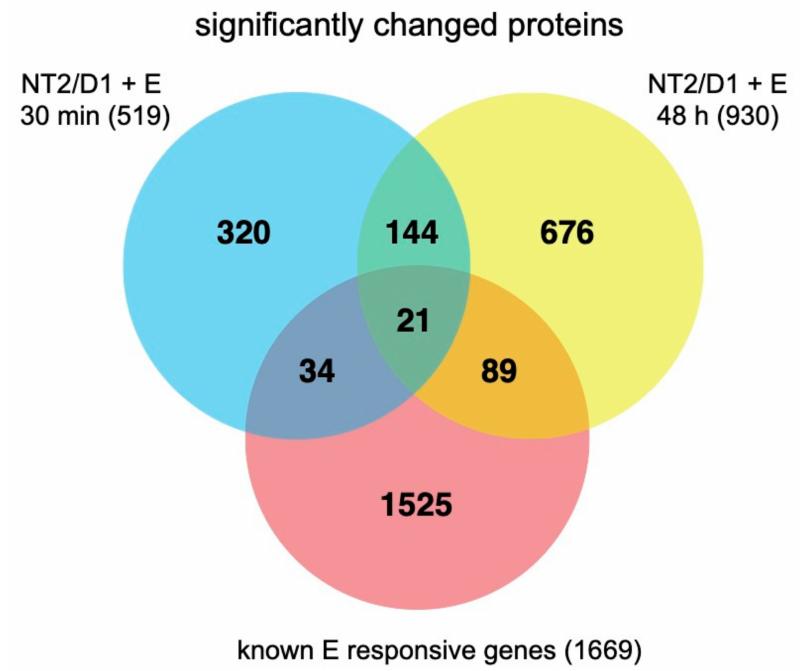
Figure 3. The number of proteins significantly changed in both 30 min (blue) or 48 h (yellow) of EE2 treatment datasets in NT2/D1 cells and their overlap with known oestrogen (E; red) responsive